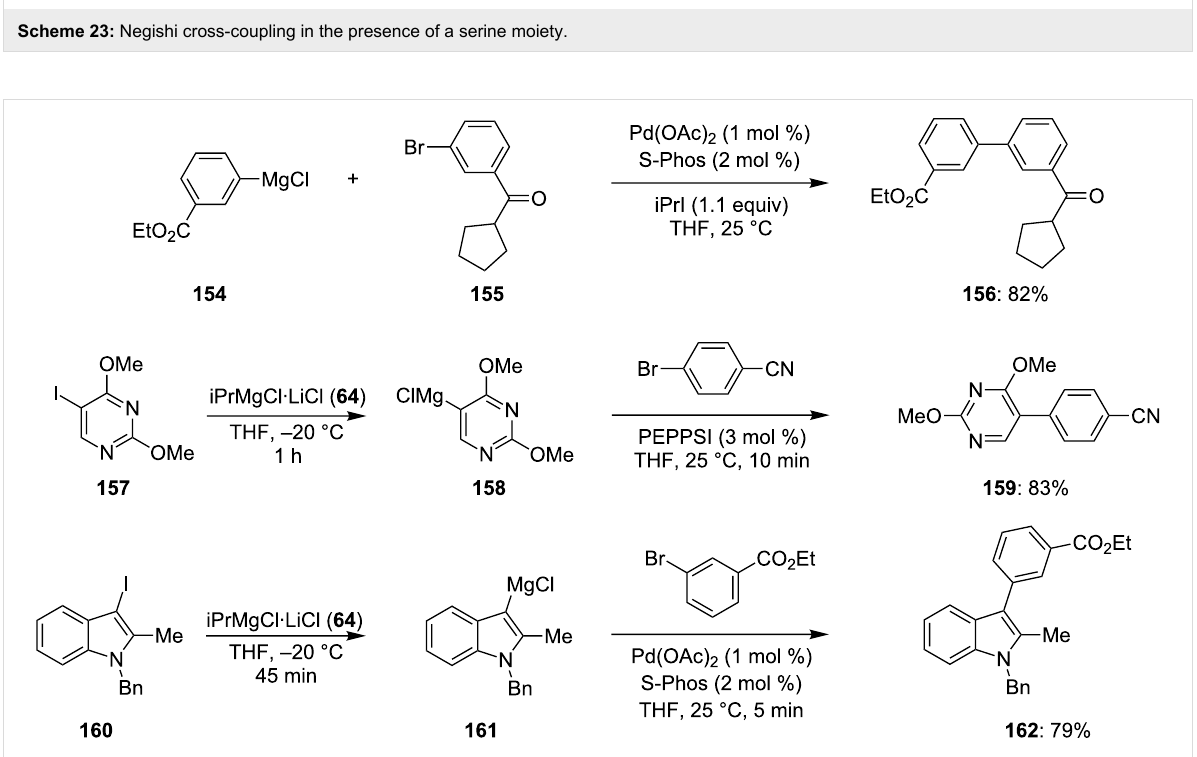
Scheme 24: Radical catalysis for the performance of very fast Kumada